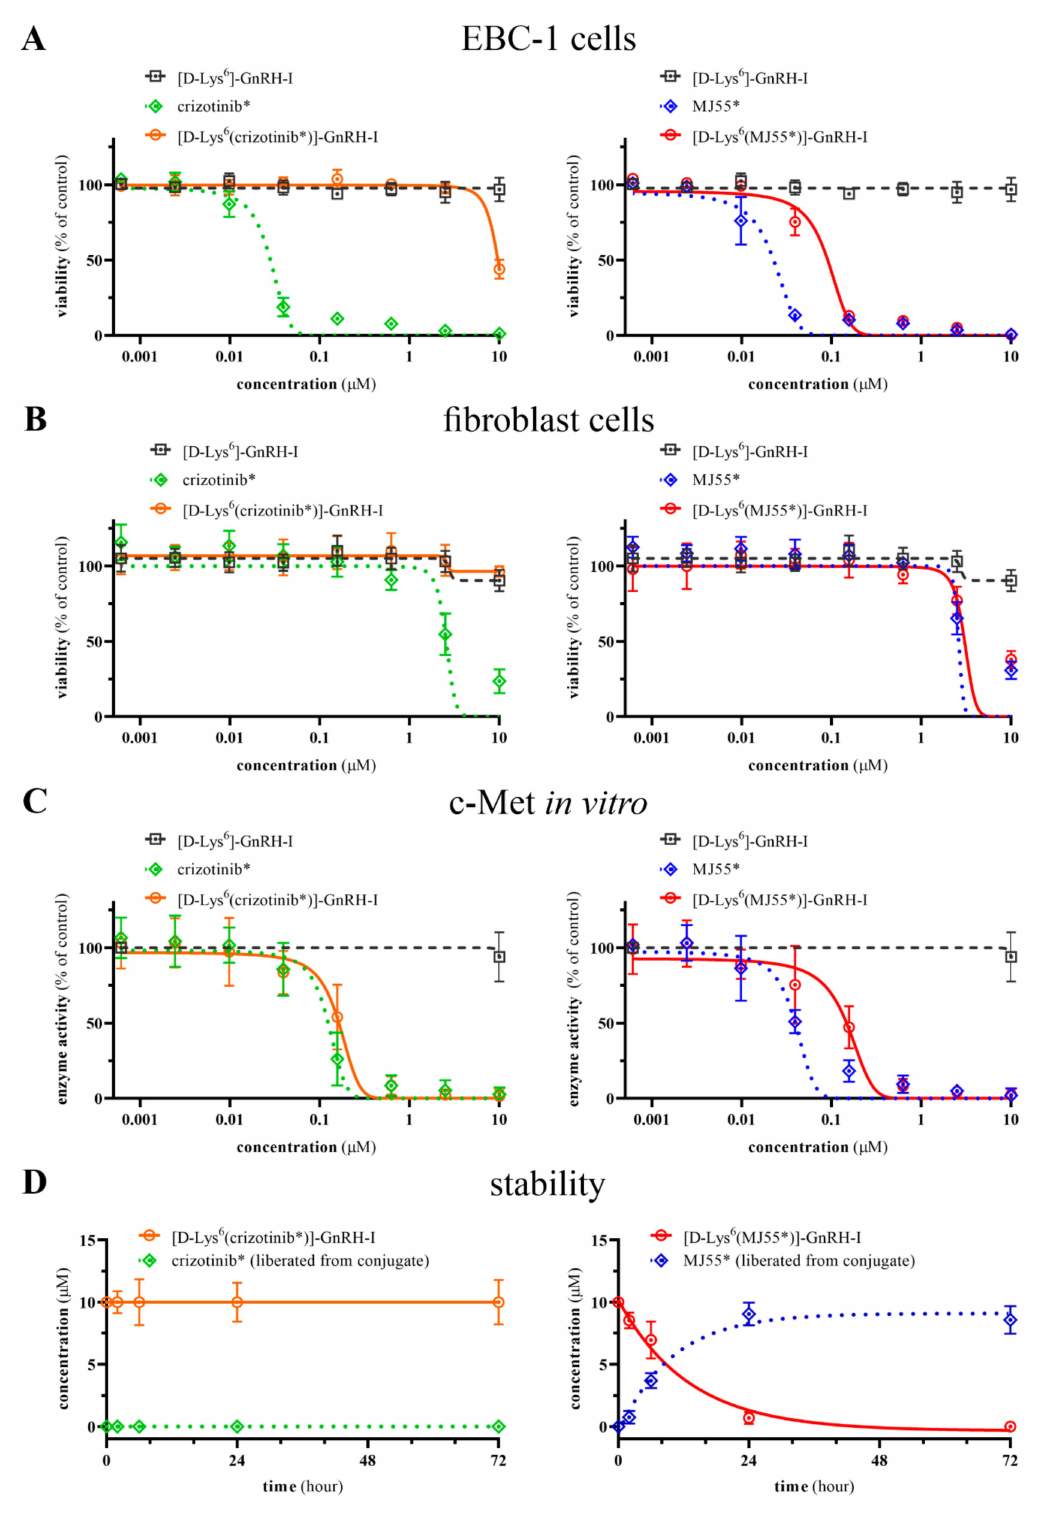
Figure 4. Biological evaluation of compounds. ( A ) Viability inhibition e ff ect on EBC-1 NSCLC cells; ( B ) viability inhibition e ff ect on human primary skin fibroblast cells; ( C ) in vitro inhibition e ff ect on the recombinant c-Met kinase; ( D ) stability in cell culture medium at 37 ◦ C; All values are the mean ± SD of at least three independent